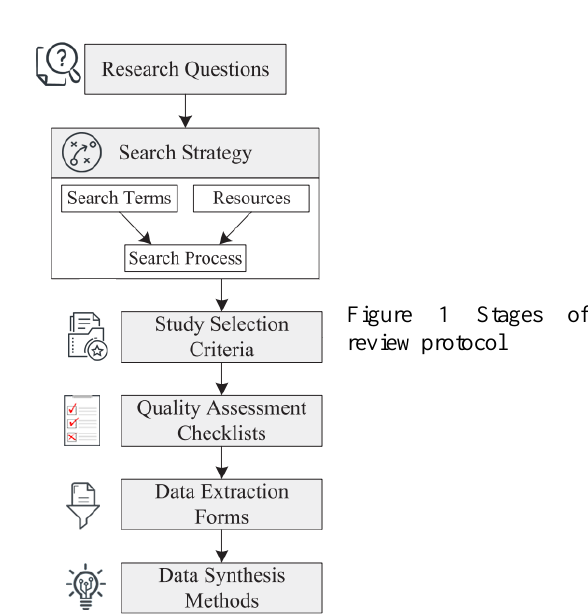
Figure 2. The stages of Systematic Literature